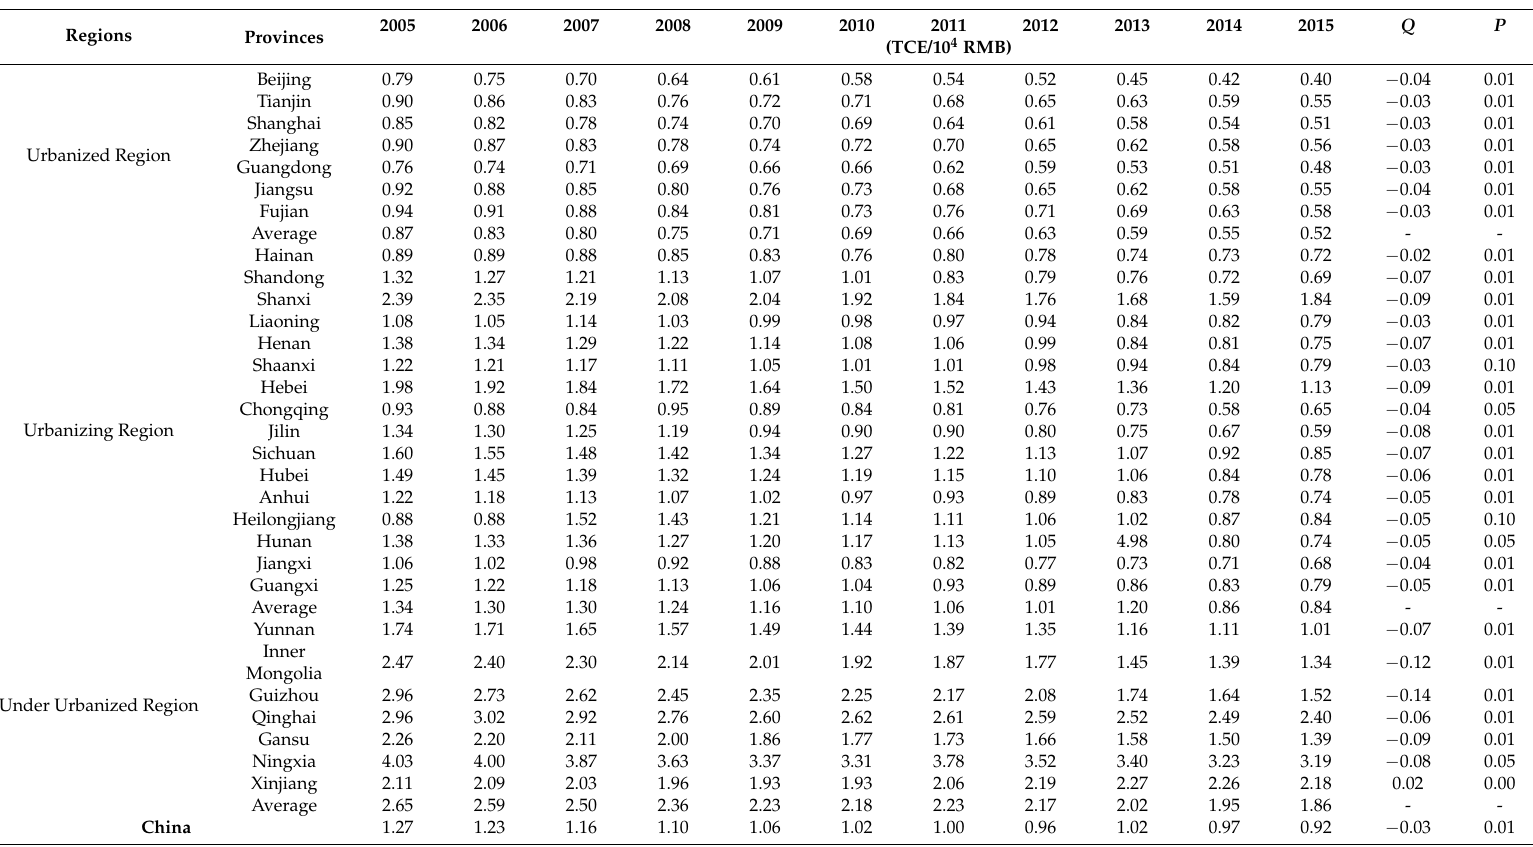
Table A4. China’s total energy consumption intensity (ECI), Sen’s slope (Q), and significance level (P) at provincial and national levels between 2005 and 2015. Regions